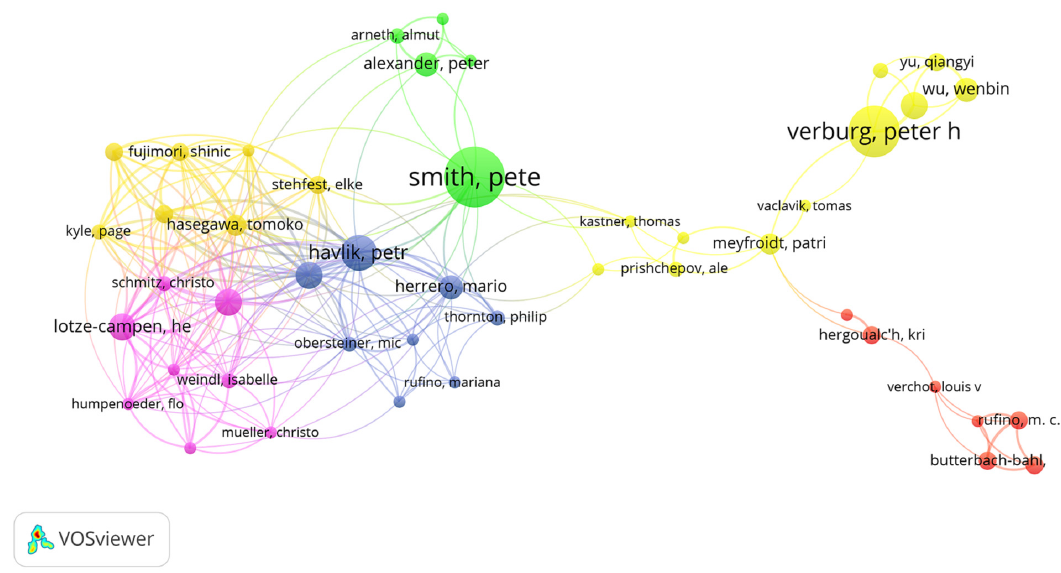
Figure 2. Author cooperation network map.